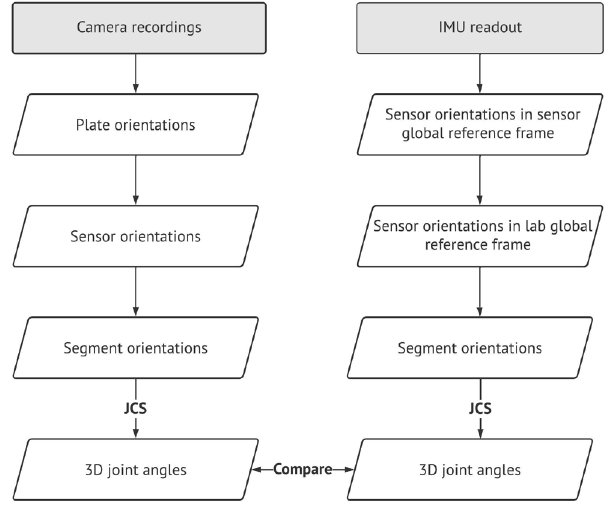
Figure 2. Flowchart of obtaining 3D joint angles of ice skating using IMU readouts and comparing them with the ones obtained by a stationary motion capture system.